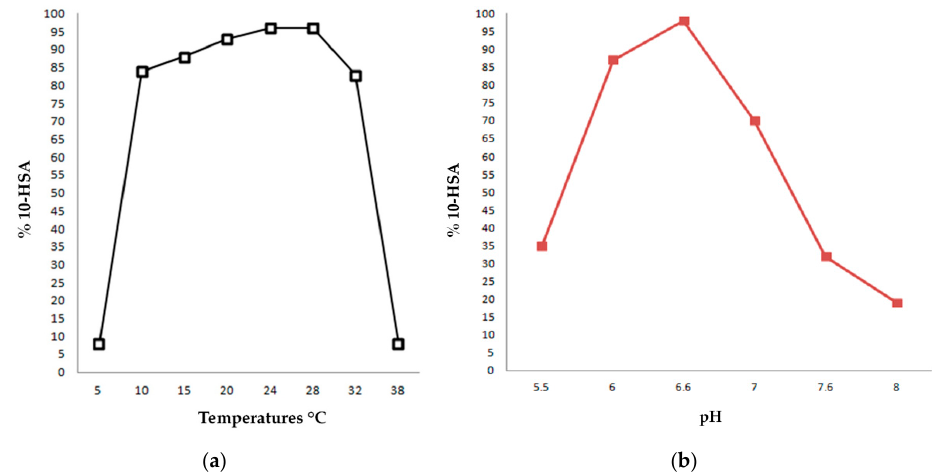
Figure 3. The influence of temperature and pH on the performances of the recombinant oleate hydratase from Lactobacillus rhamnosus ATCC 53103. ( a ) The yields of 10-hydroxystearic acid (10-HSA) at di ff erent temperatures are reported (pH 6.6, starting concentration of OA: 3 g / L). ( b ) The yields of 10-HSA at di ff erent pHs are reported (28 ◦ C, starting concentration of OA: 3 g /